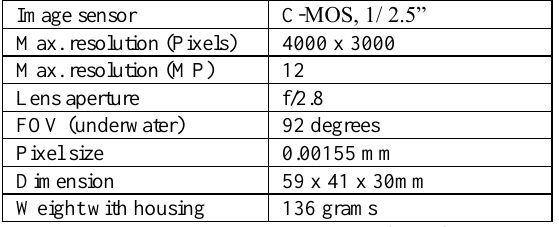
Table 1: Specification GoPro 3 (Black).